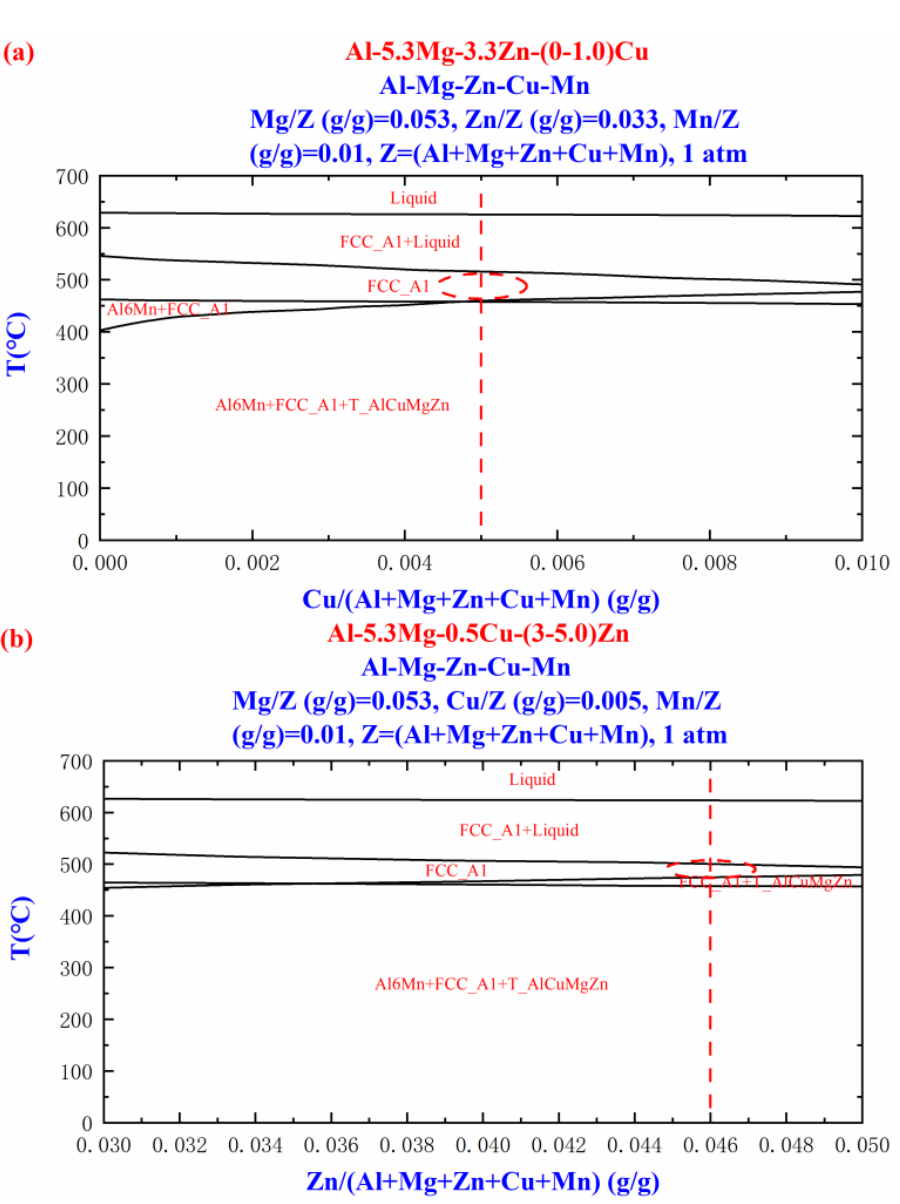
Figure 3. Phase diagram of Al-Mg-Zn-Cu alloys calculated by FactSage software: ( a ) Al-5.3Mg-3.3Zn-xCu, ( b ) Al-5.3Mg-0.5Cu-xZn [19].